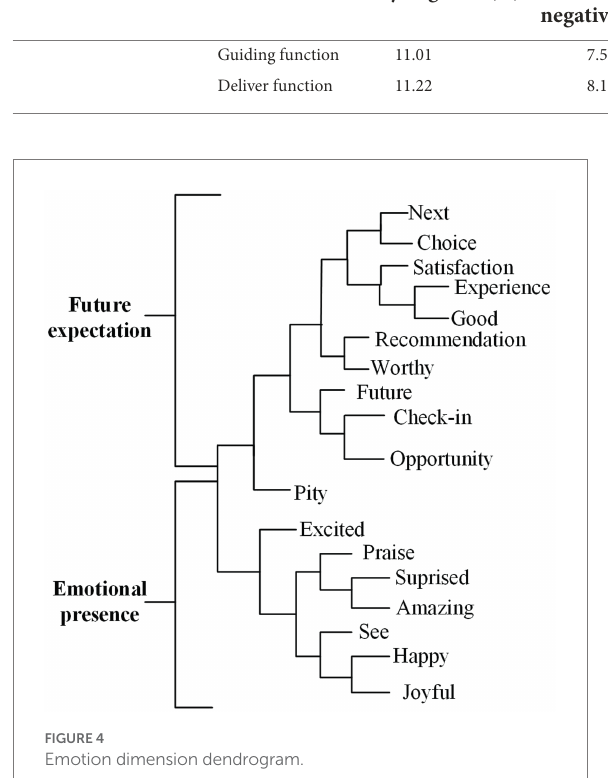
TABLE 3 Sentiment analysis of performance efficiency dimension. N valid cases = 2,275 Cluster